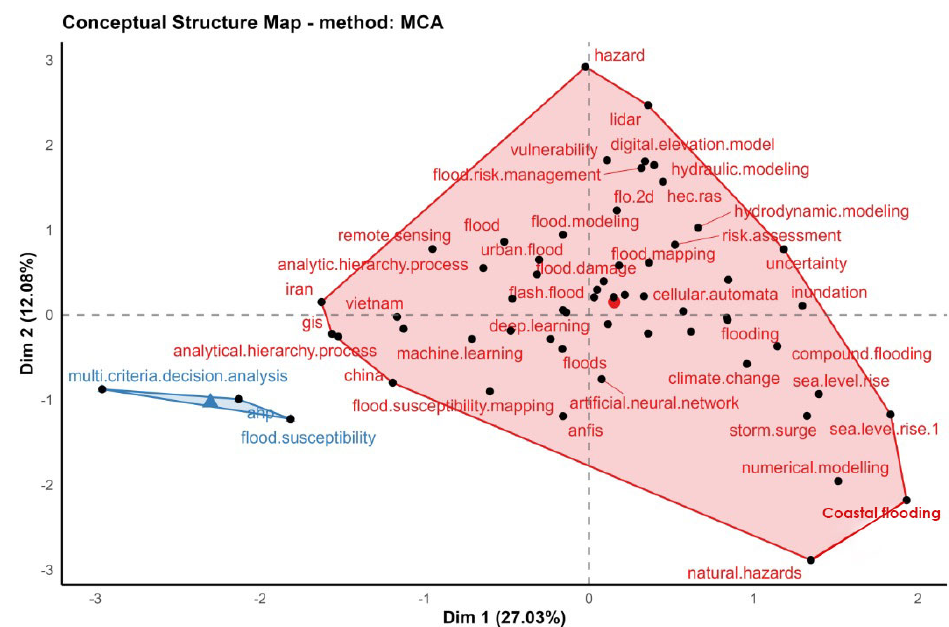
Figure 8. Conceptual structure Map according to Multiple Correspondence Analysis